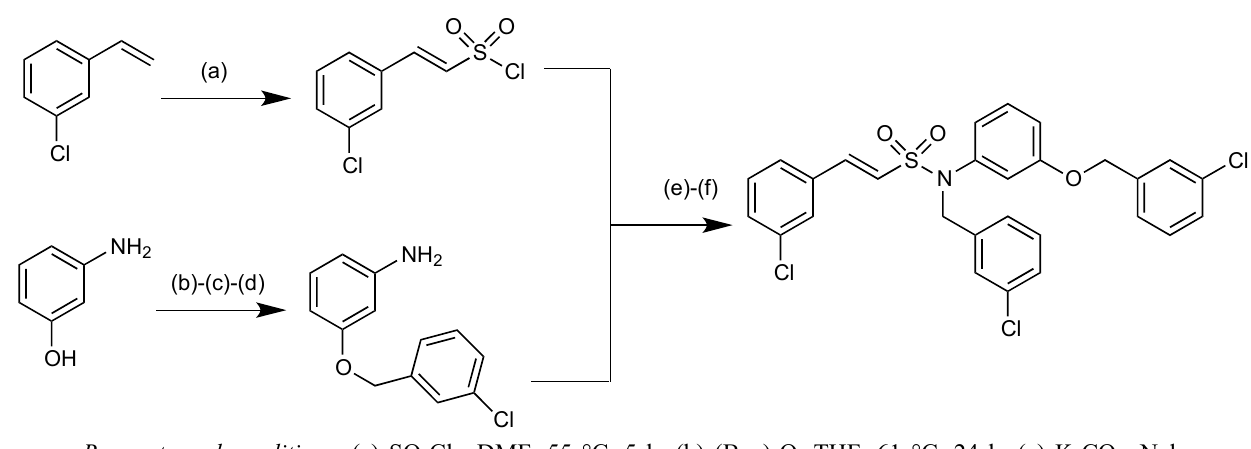
Figure 19. Chemical synthesis of representative sulphonamido β-lactamase inhibitors.